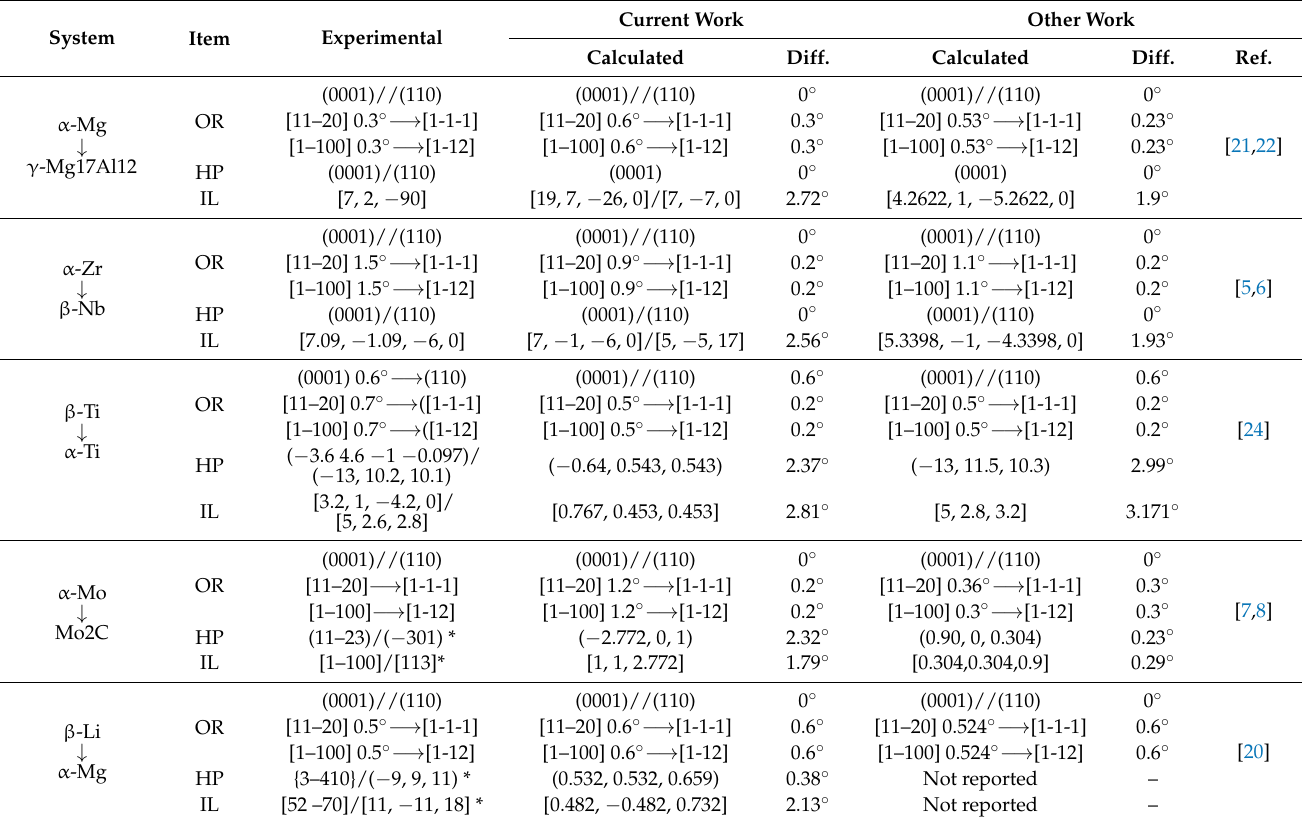
Table 3. Comparison of crystallographic features of HCP–BCC diffusional transformations between literature and current